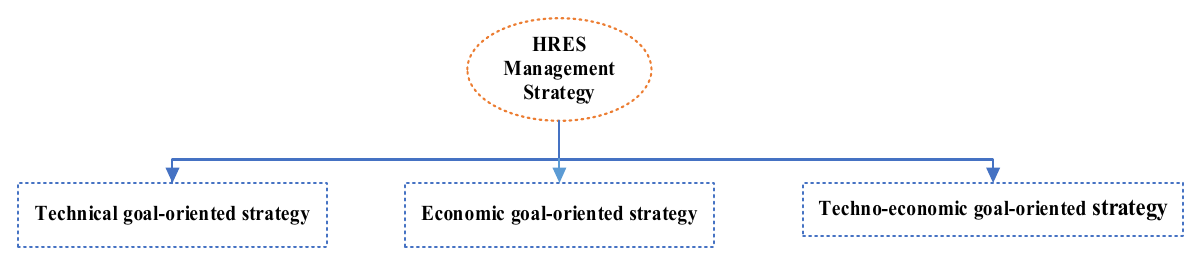
Figure 4. Intelligent energy flow structure.